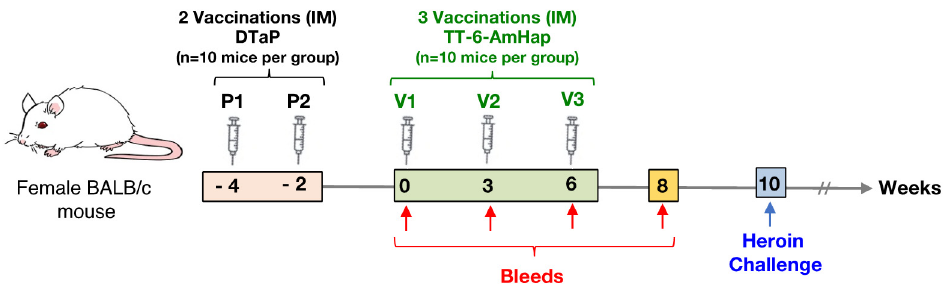
Figure 1. Study design for testing TT-6-AmHap vaccine efficacy in mice primed with DTaP. Groups of 10 mice were pre-immunized intramuscularly (IM) with increasing doses of DTaP (P1, P2) at weeks -4 and -2. Blood was collected from all mice prior to each vaccination with TT-6-AmHap. Mice were vaccinated with 10 µ g TT-6-AmHap (V1, V2, V3) intramuscularly in alternate rear thighs at weeks at 0, 3, and 6. All mice, including heroin vaccine only (unprimed) and negative (naive) controls, were challenged with 1 mg/kg heroin SC at week 10. The hot plate test and locomotion assay were used to assess TT-6-AmHap vaccine efficacy in response to the heroin challenge.